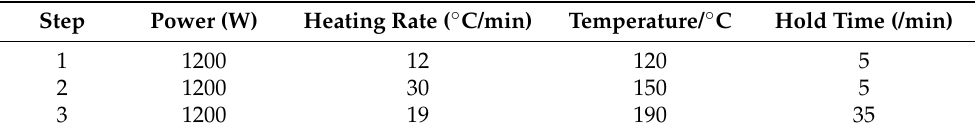
Table 3. Parameters during the microwave digestion